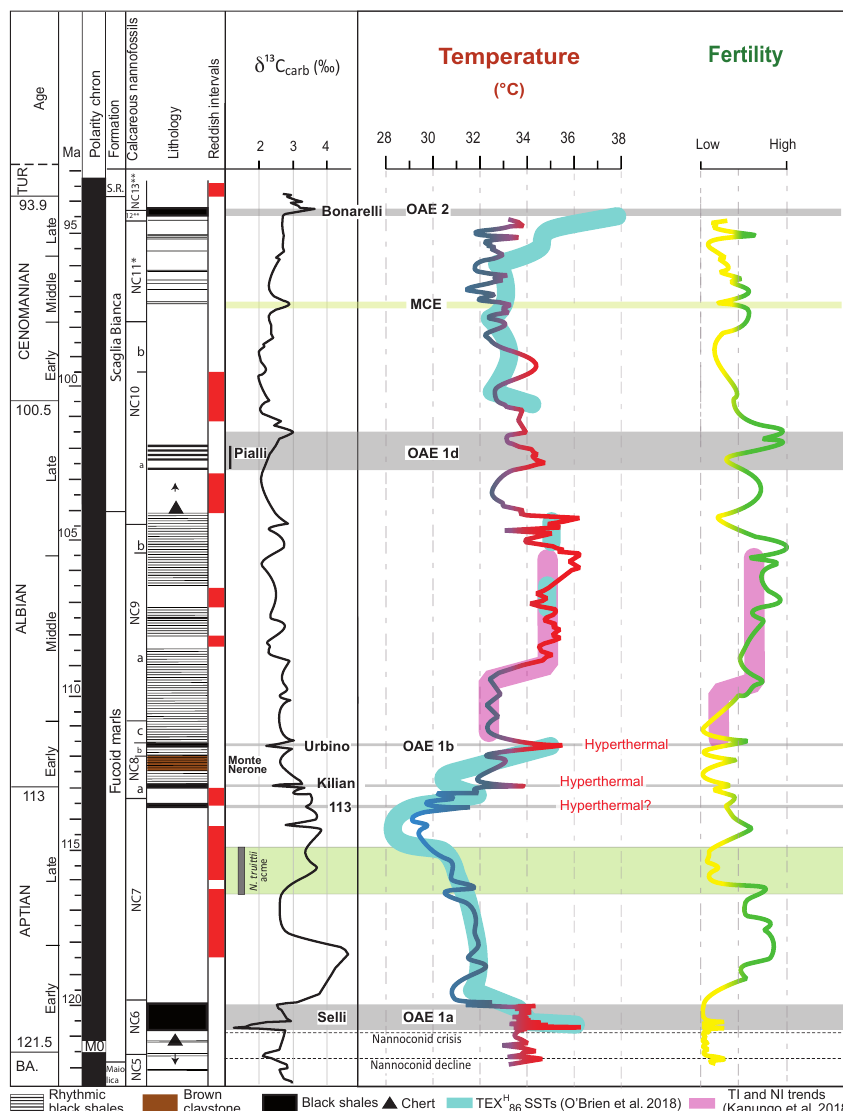
Figure 7. Synthesis of nannofossil-based nutrient (NI) and temperature (m-TI) variations reconstructed in the western Tethys as in Fig. 6. Nannofossil-derived SSTs ( ◦ C) are calibrated to TEX 86 SSTs as in Fig. 6. Simplified TEX H are reported in light blue. Middle Albian nannofossil TI and NI trends (pink lines) are from the Gault Clay Formation (Kanungo et al., 2018). Timescale is after Malinverno et al. (2010, 2012) for the late Barremian–Aptian and after the Geological Time Scale 2012 (Gradstein et al., 2012) for the